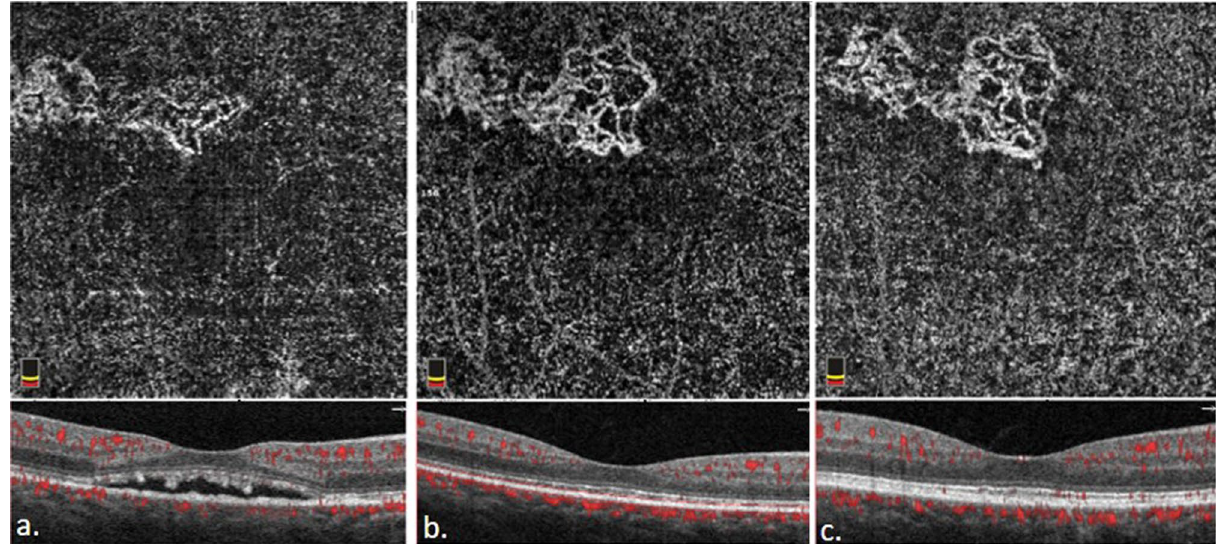
Figure 2. Optical coherence tomography and optical coherence tomography angiography of case 5 before half dose photodynamic therapy (PDT) ( a ). One month after treatment ( b ), the subretinal fluid was reabsorbed completely and choroidal neovascularization (CNV) network was more clearly visible. 3-year after first half-dose PDT( c ), the size of CNV had enlarged from 0.763 mm 2 one month after treatment to 1.025 mm 2 three years after treatment.